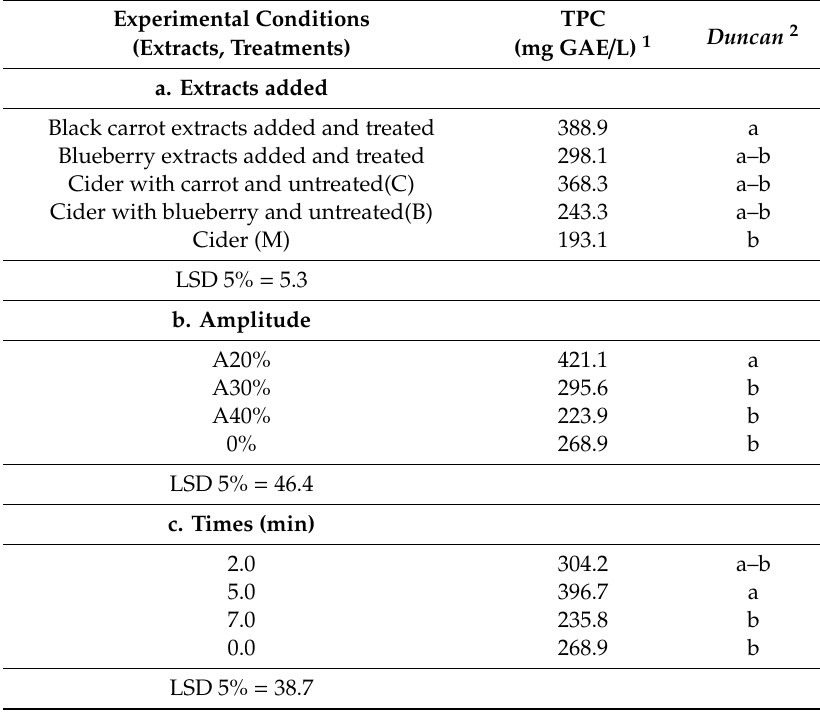
Table 3. Influences of the ( a ) extracts additions, ( b ) sonication amplitude and ( c ) sonication times on TPC.